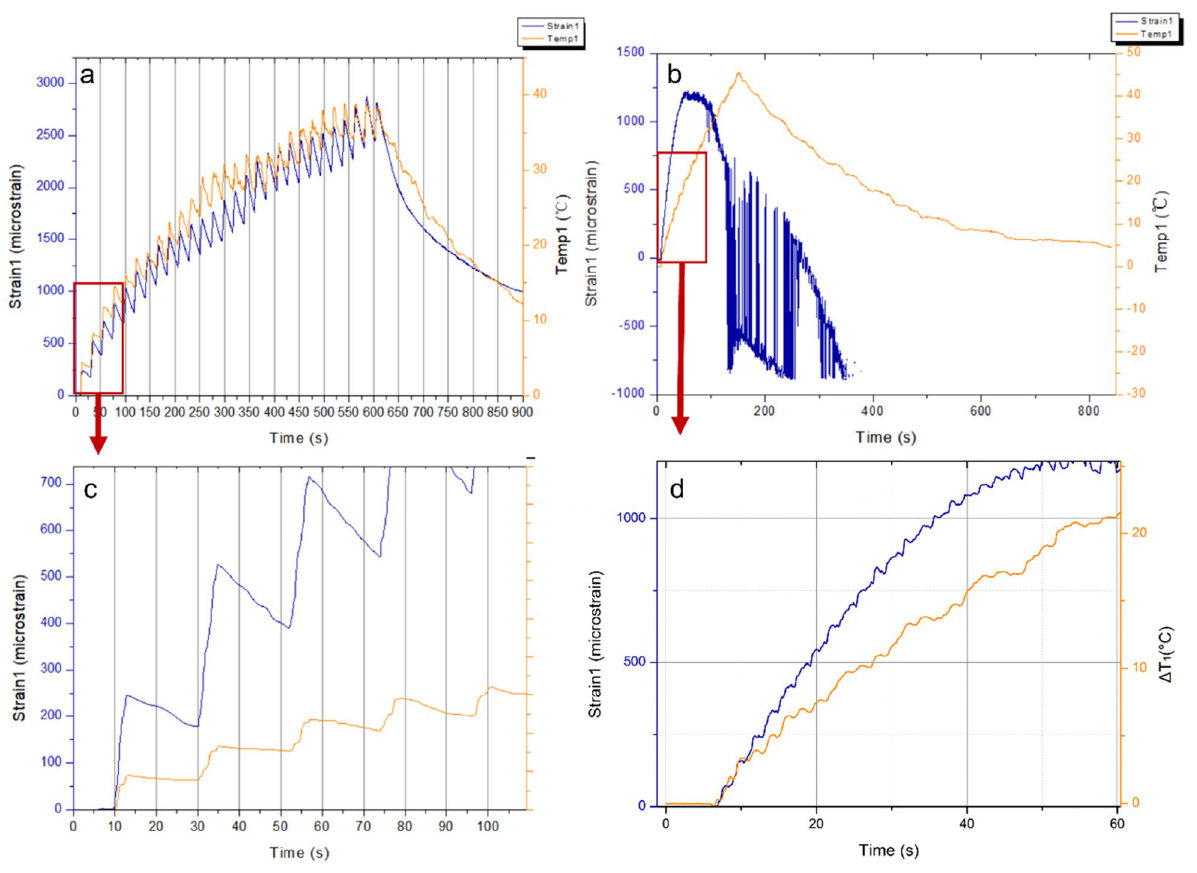
Figure 23. Strain and temperature measurements of FBG sensor 1 of ( a ) and ( c ) 15 wt.% BaTiO 3 /Epoxy nanocomposite sample under 100 W for 600 s, ( b ) and ( d ) 15 wt.% BaTiO 3 -Epoxy nanocomposite sample under 440 W for 148 s.